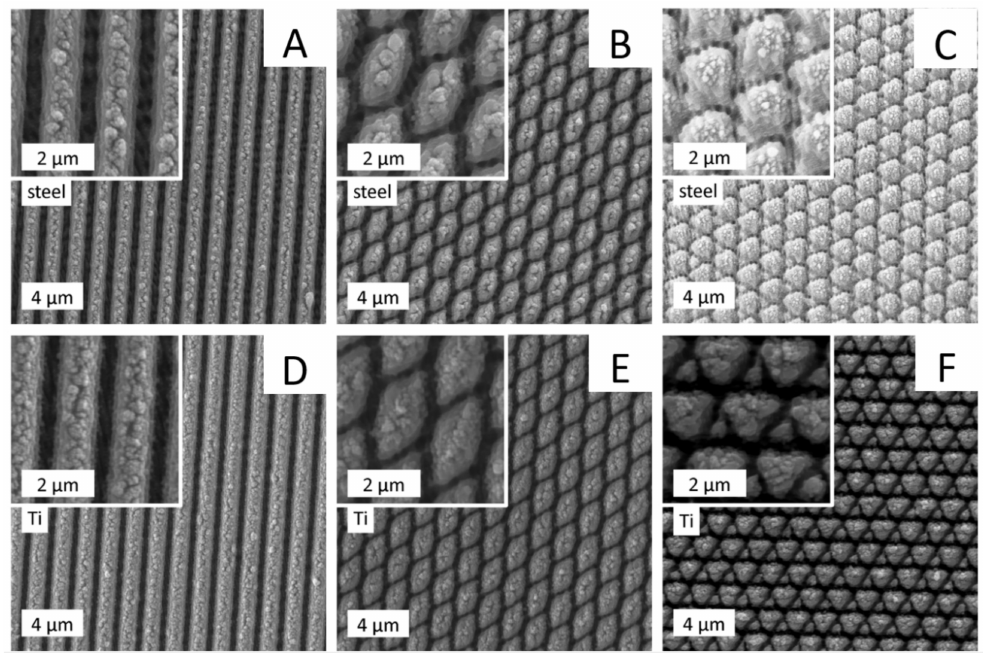
Figure 5. Scanning electron microscopy (SEM) examination of nanostructures. Stainless steel ( A – C ) and titanium ( D – F ) plates were analyzed using scanning electron microscopy. The following structures are shown: A and D: 1-5; B and E: 2-5; C and F: 5-5.